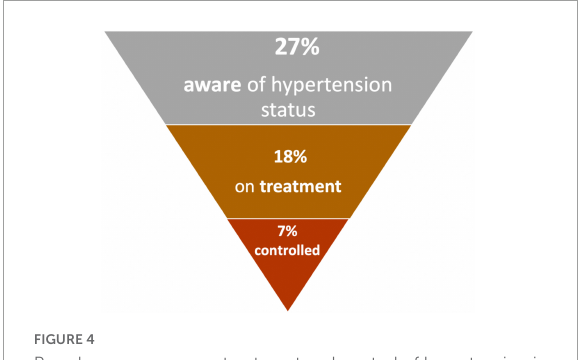
FIGURE4 Prevalence, awareness, treatment and control of hypertension in Africa